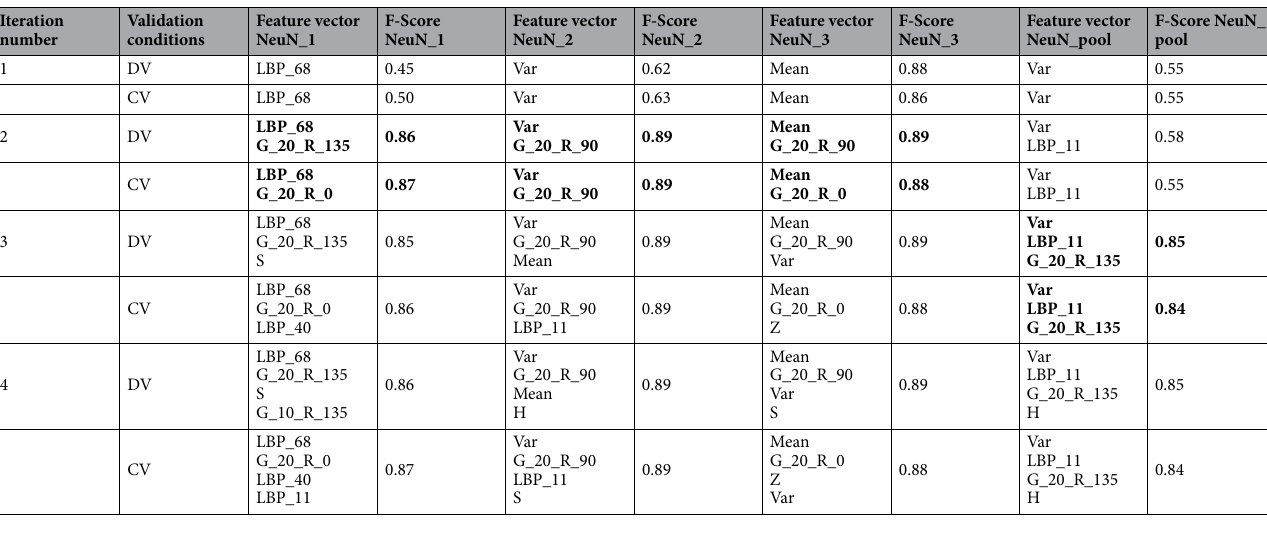
Table 5. Feature selection results for the NeuN datasets. Bold vector corresponds to the selected vector. The nomenclature is presented in Material and Methods.